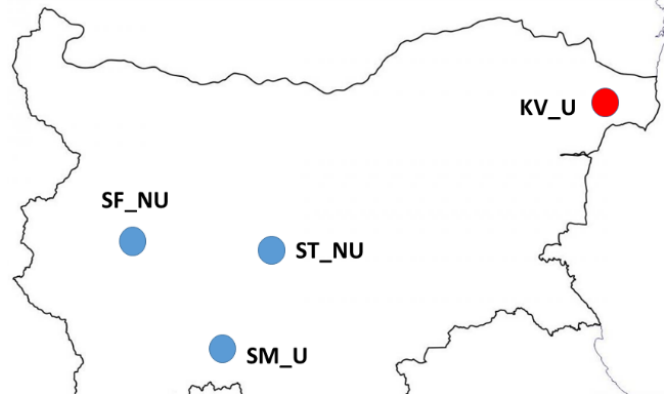
Figure 1. Map showing the locations of 20 honey samples in Bulgaria. Sample names indicate the region in Bulgaria (SF, Sofia City Province; SM, Smolyan; ST, Strelcha; KV, Kavarna). Habitat indicator (U, urban area; NU, non-urban area). Blue circles—polyfloral honey; Red circle—monofloral honey.